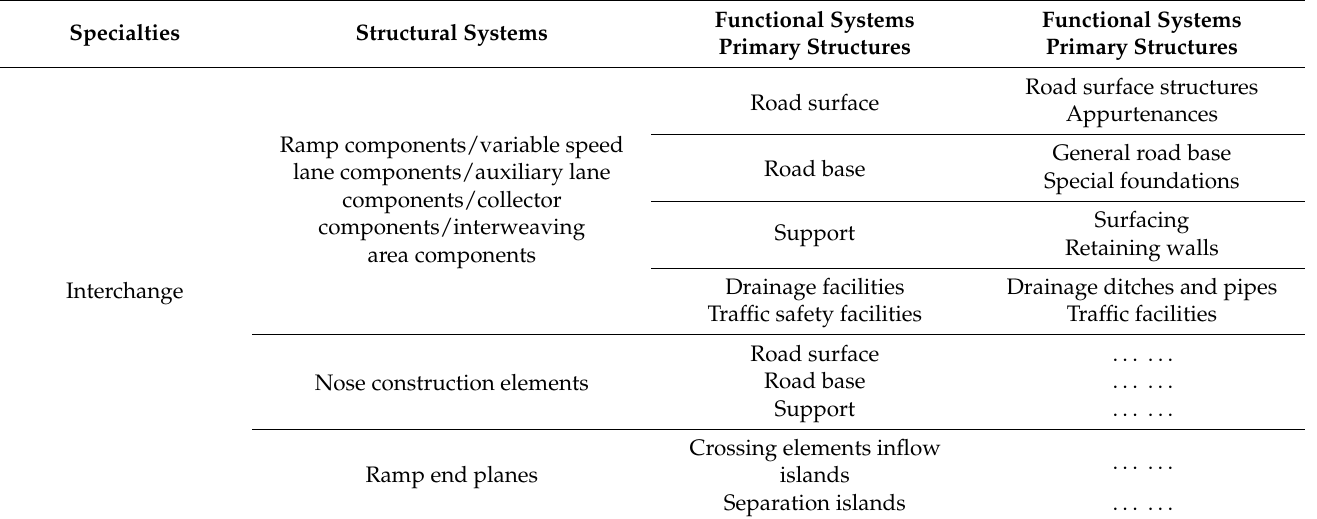
Table 1. Interchange BIM